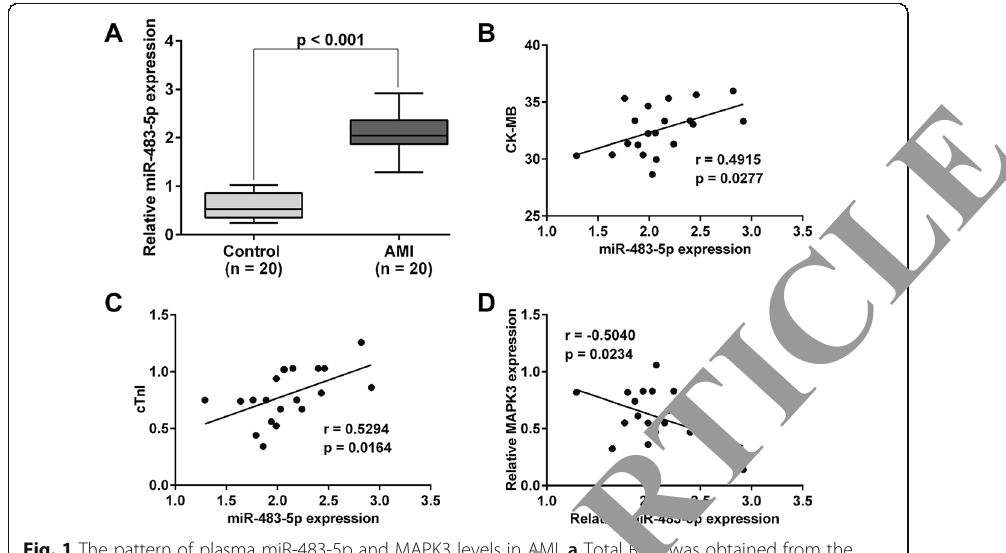
Fig. 1 The pattern of plasma miR-483-5p and MAPK3 levels in AMI. a Total RNA was obtained from the plasma derived from AMI patients ( n = 20) and healthy controls ( n = 20) and subjected to quantitative real- time PCR for miR-483-5p expression. b through d Spearman rank correlation analyses were performed to investigate the relationships between miR-483-5p and CK-MB, cTnI and MAPK3. r = Spearman rank correlation coefficient; p = significance of correlation